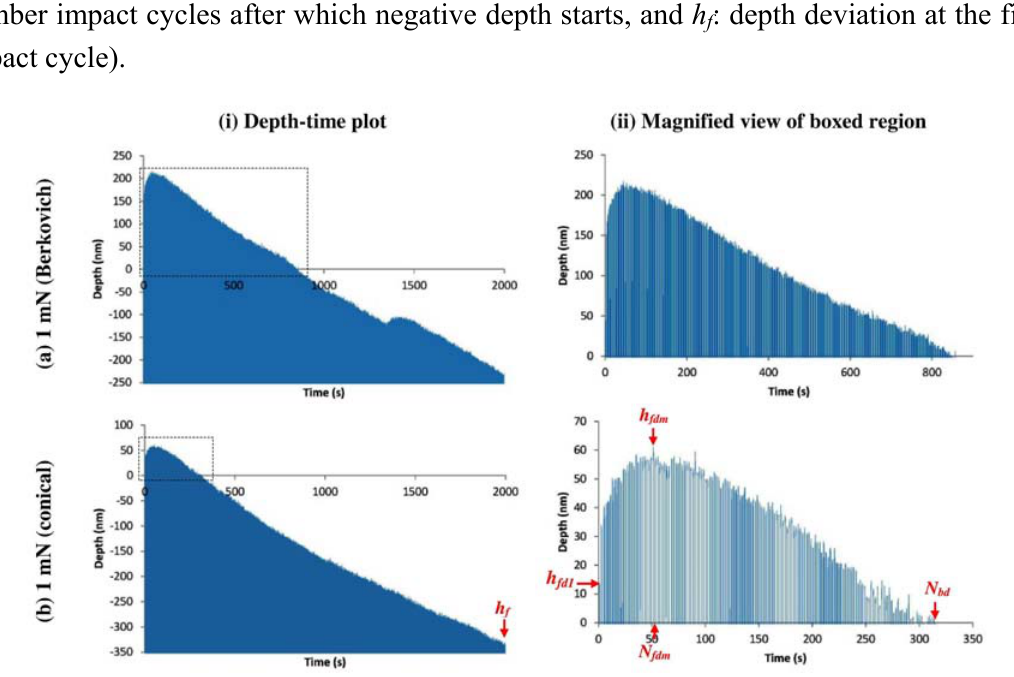
: maximum forward depth fdm : bd : depth deviation at the final f